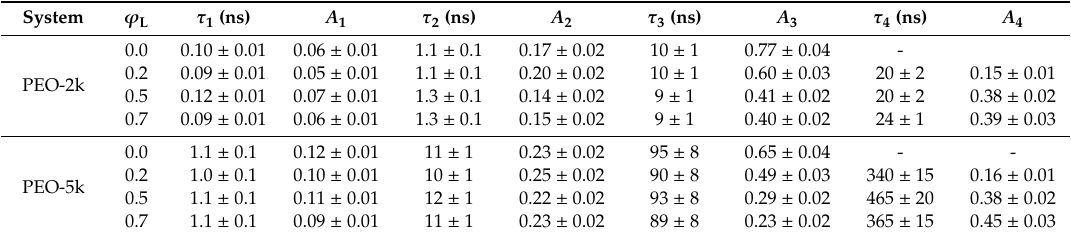
Table 3. MD predictions for the values of the set of characteristic relaxation times τ 1 , τ 2 , τ 3 and τ 4 and pre-exponential constants A 1 , A 2 , A 3 and A 4 quantifying ring terminal relaxation in the simulated blends. For direct comparison, we also report the corresponding values for R-2k and R-5k rings in their pure melts from the corresponding analysis of the simulation trajectories presented in Ref. [25]. System ϕ L τ 1